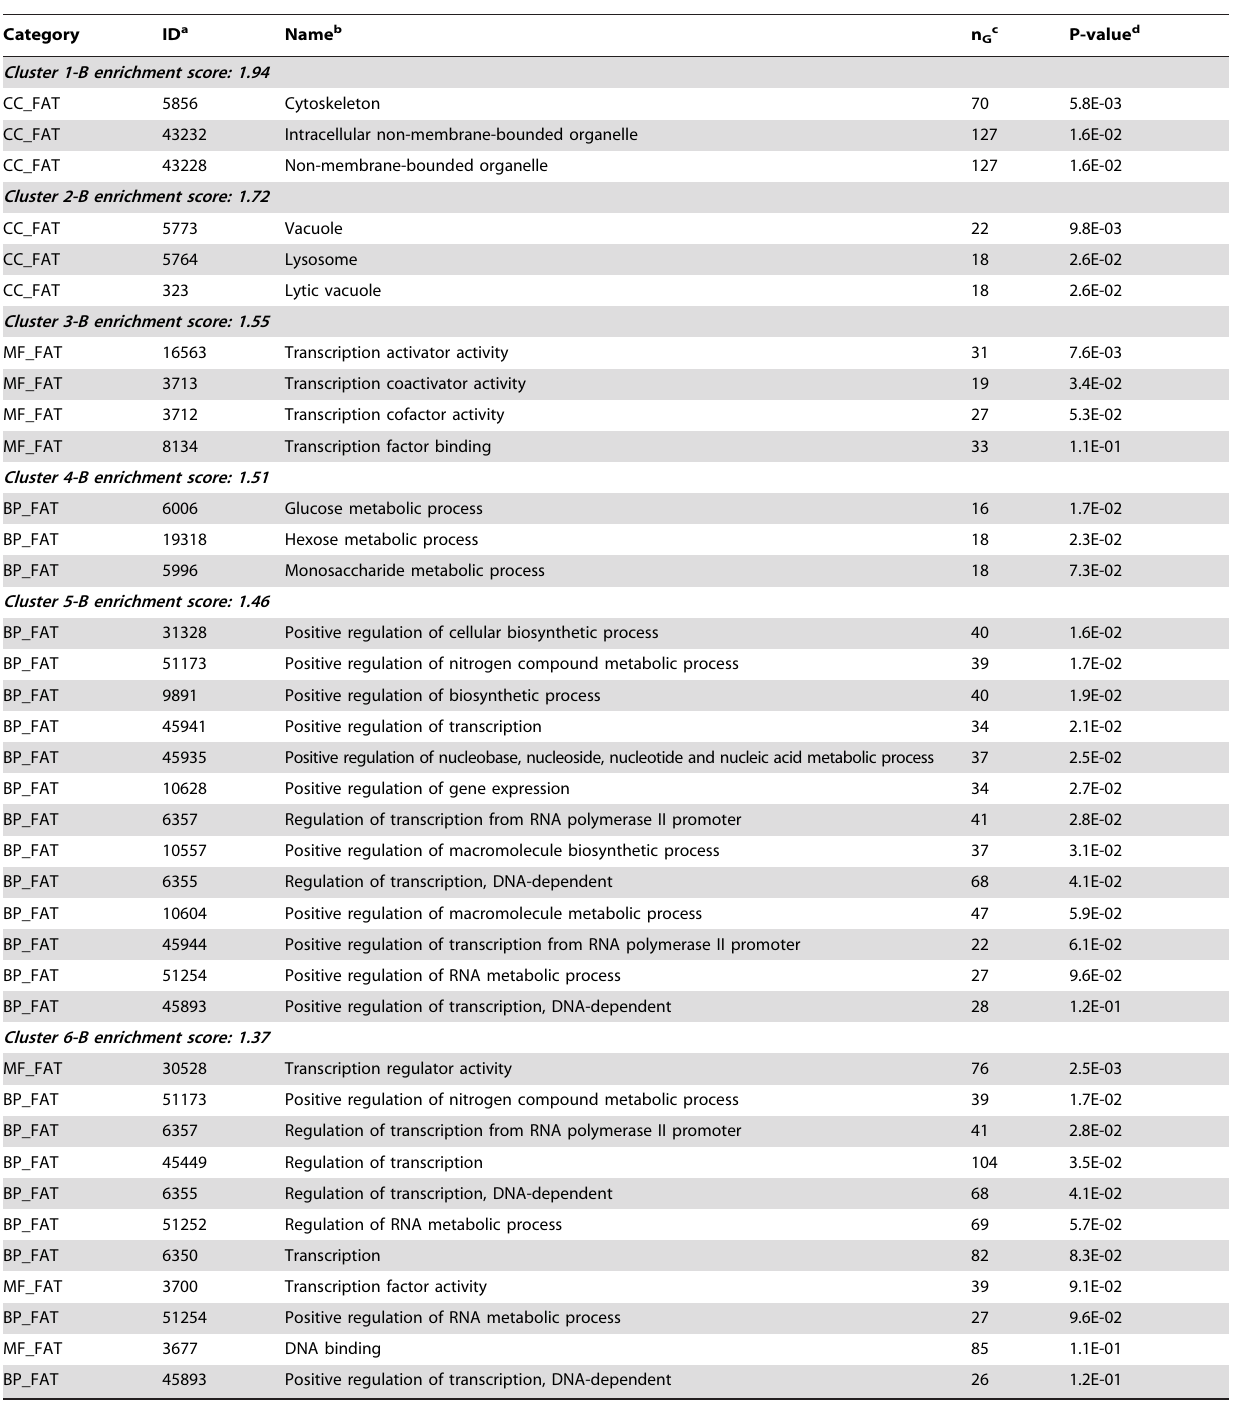
Table 5. Functional annotation clustering for genes highly expressed in the Longissimus muscle of Basque (B, n =20) pigs.